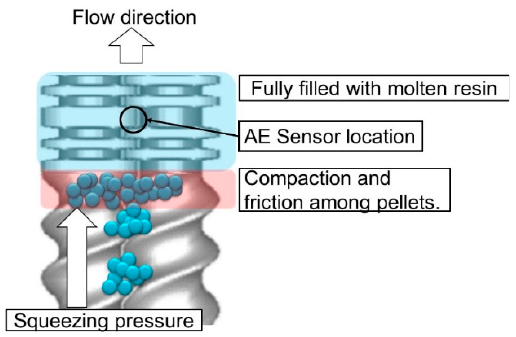
Figure 9. Holdup of pellets by the kneading disk in the twin-screw extruder.